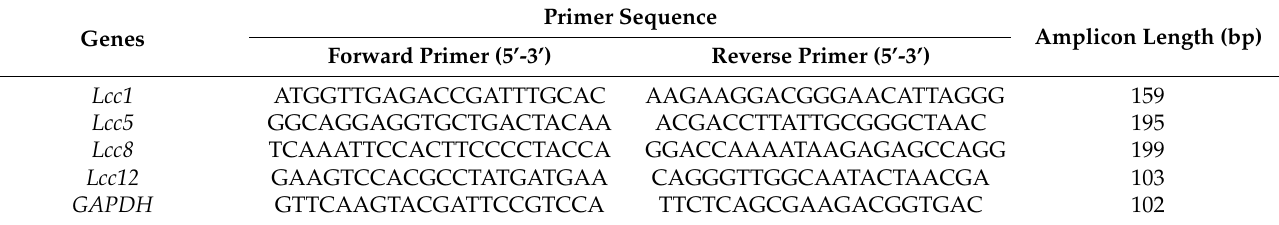
Amplicon Length (bp)